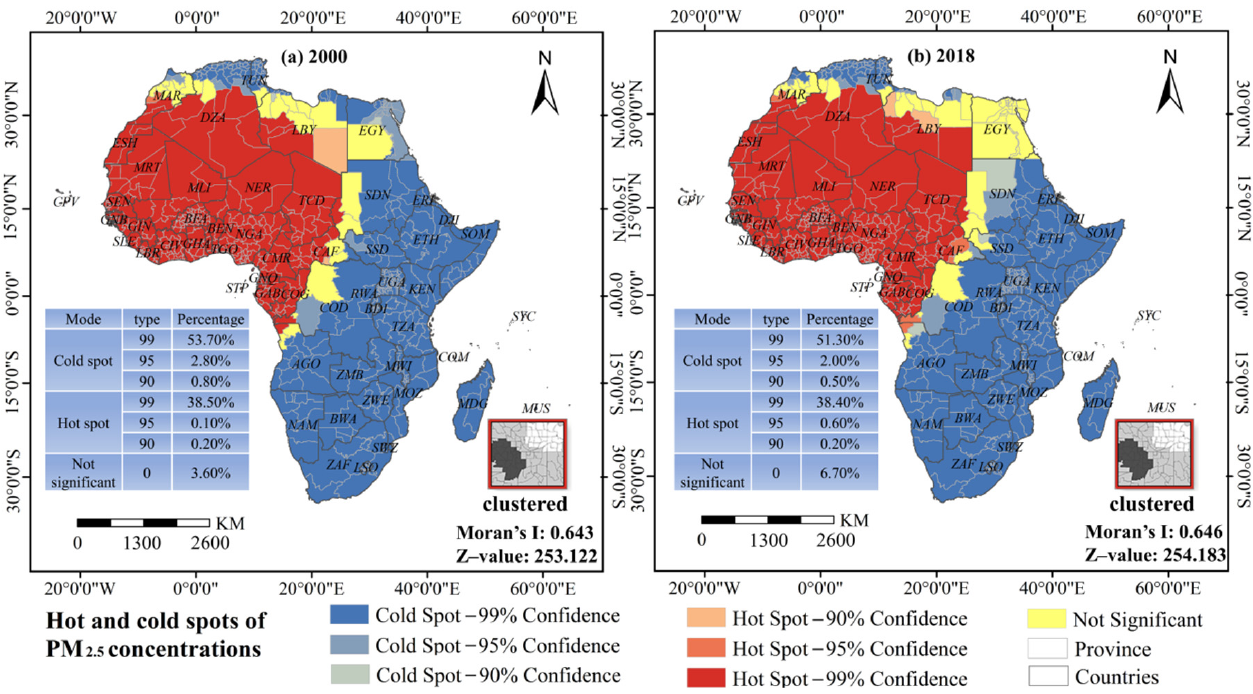
Figure 8. Hot and cold spots distributions of PM 2.5 concentrations in Africa in 2000 and 2018.